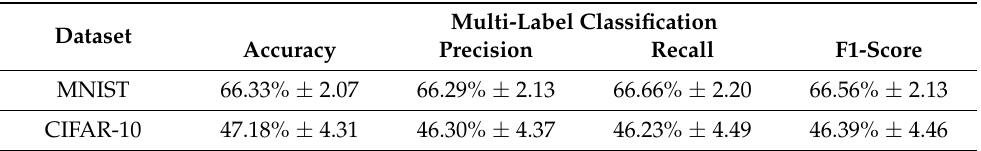
Table 5. Experimental results for multi-label classification with Carrara et al.’s method and Fea- ture